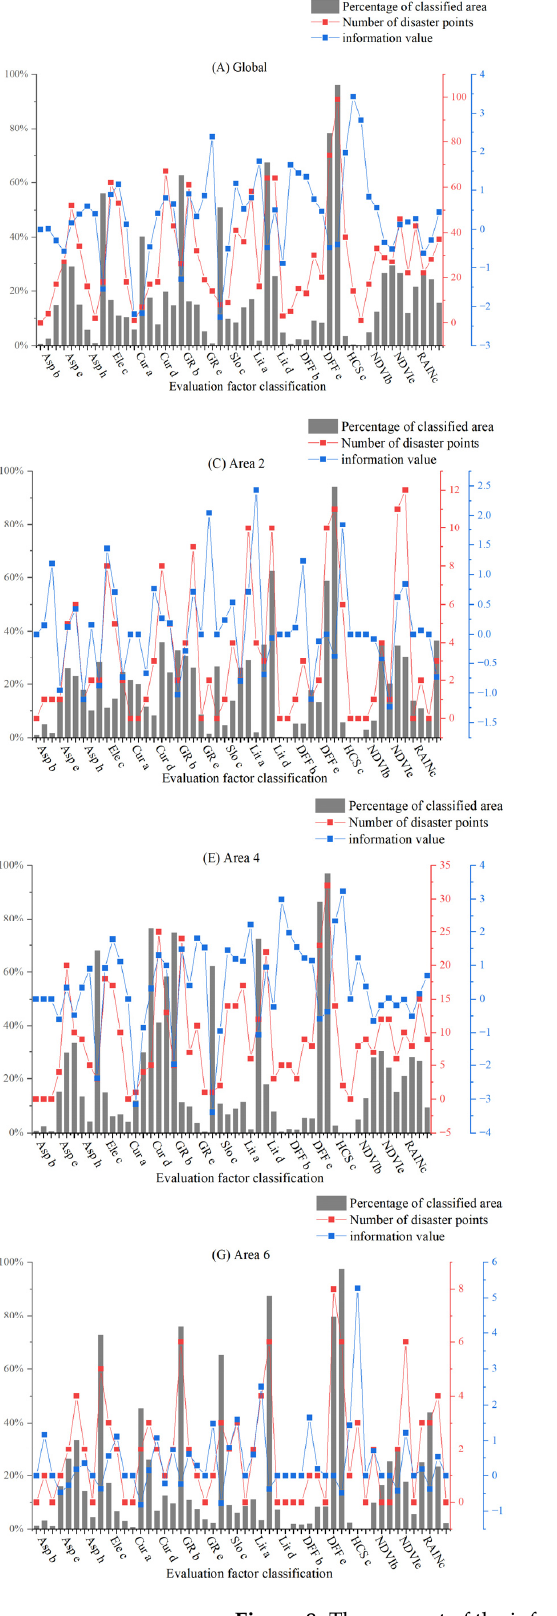
Figure 8. The amount of the information value and the distribution of disaster points in the evaluation factor classification.